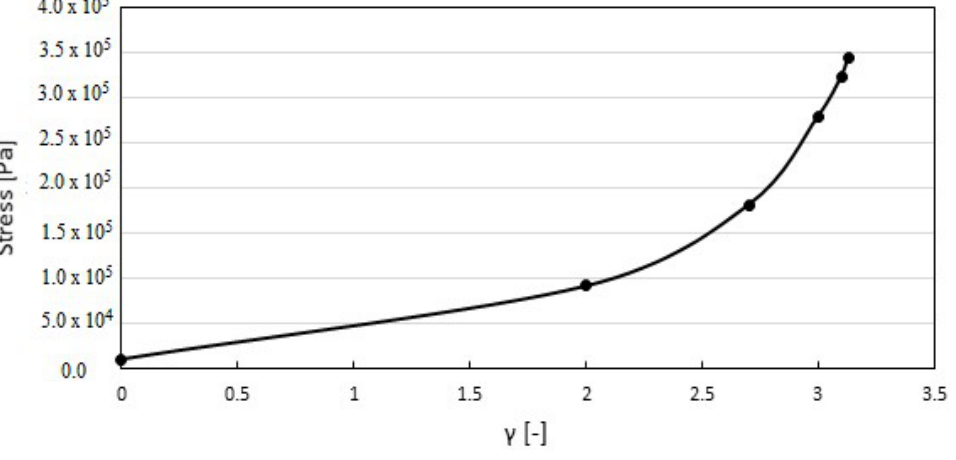
Figure 6. Stress at different degrees of calcification.